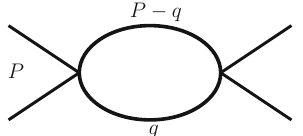
Fig. 11 Diagram corresponding to the loop function for K ∗ ¯ K